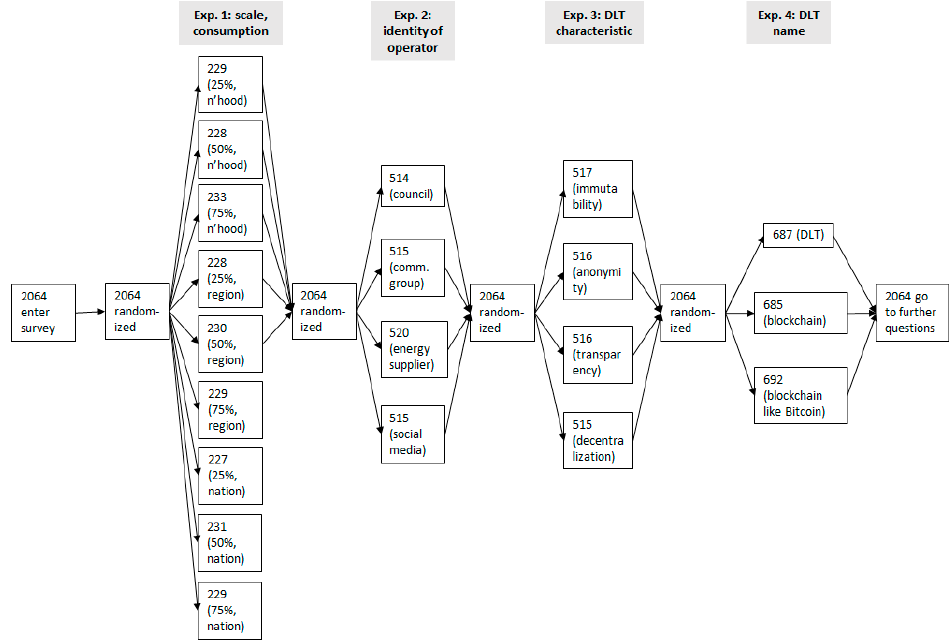
Figure 2. Participant flow through the experiment, showing number of participants in each group.